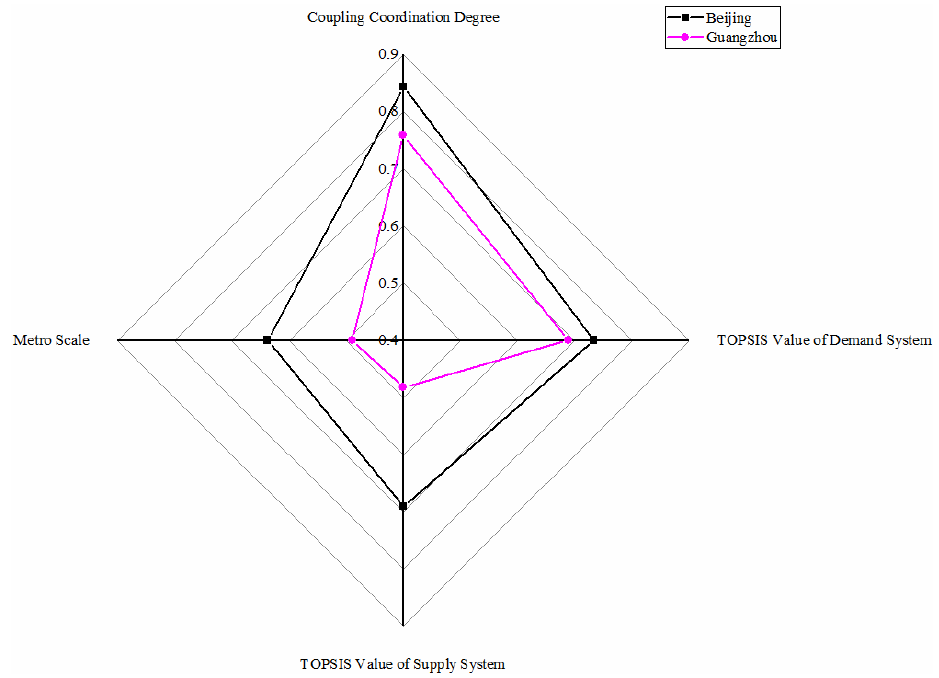
Figure 4. Metros in highly balanced with lagging supply